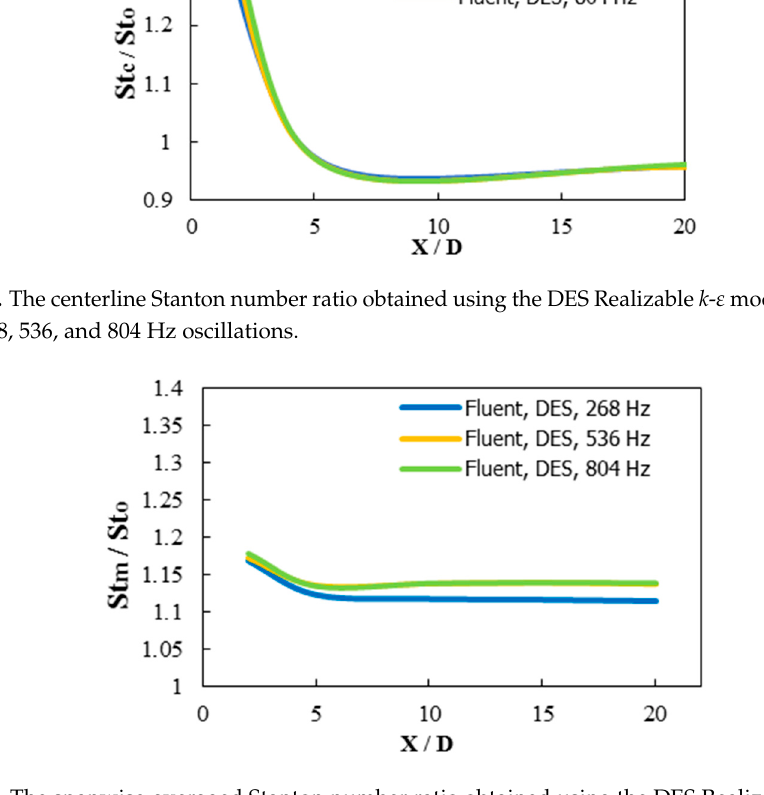
Figure 28. The spanwise-averaged Stanton number ratio obtained using the DES Realizable k - ε model for M = 0.5 for the 268, 536, and 804 Hz oscillations.